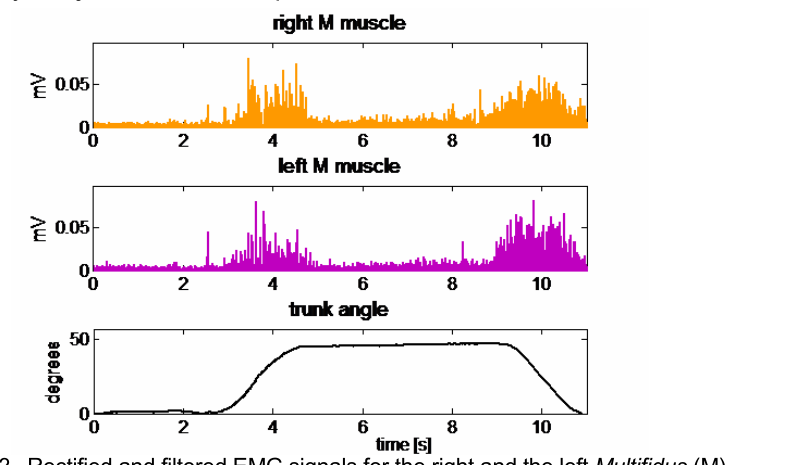
Figure 2 – Rectified and filtered EMG signals for the right and the left Multifidus (M), and the trunk angle in a healthy subject Slika 2 – Ispravljeni i filtrirani EMG signali mereni na desnom i levom Multifidus miši ć u ( right M i left M , respektivno) i ugao trupa za jednog zdravog